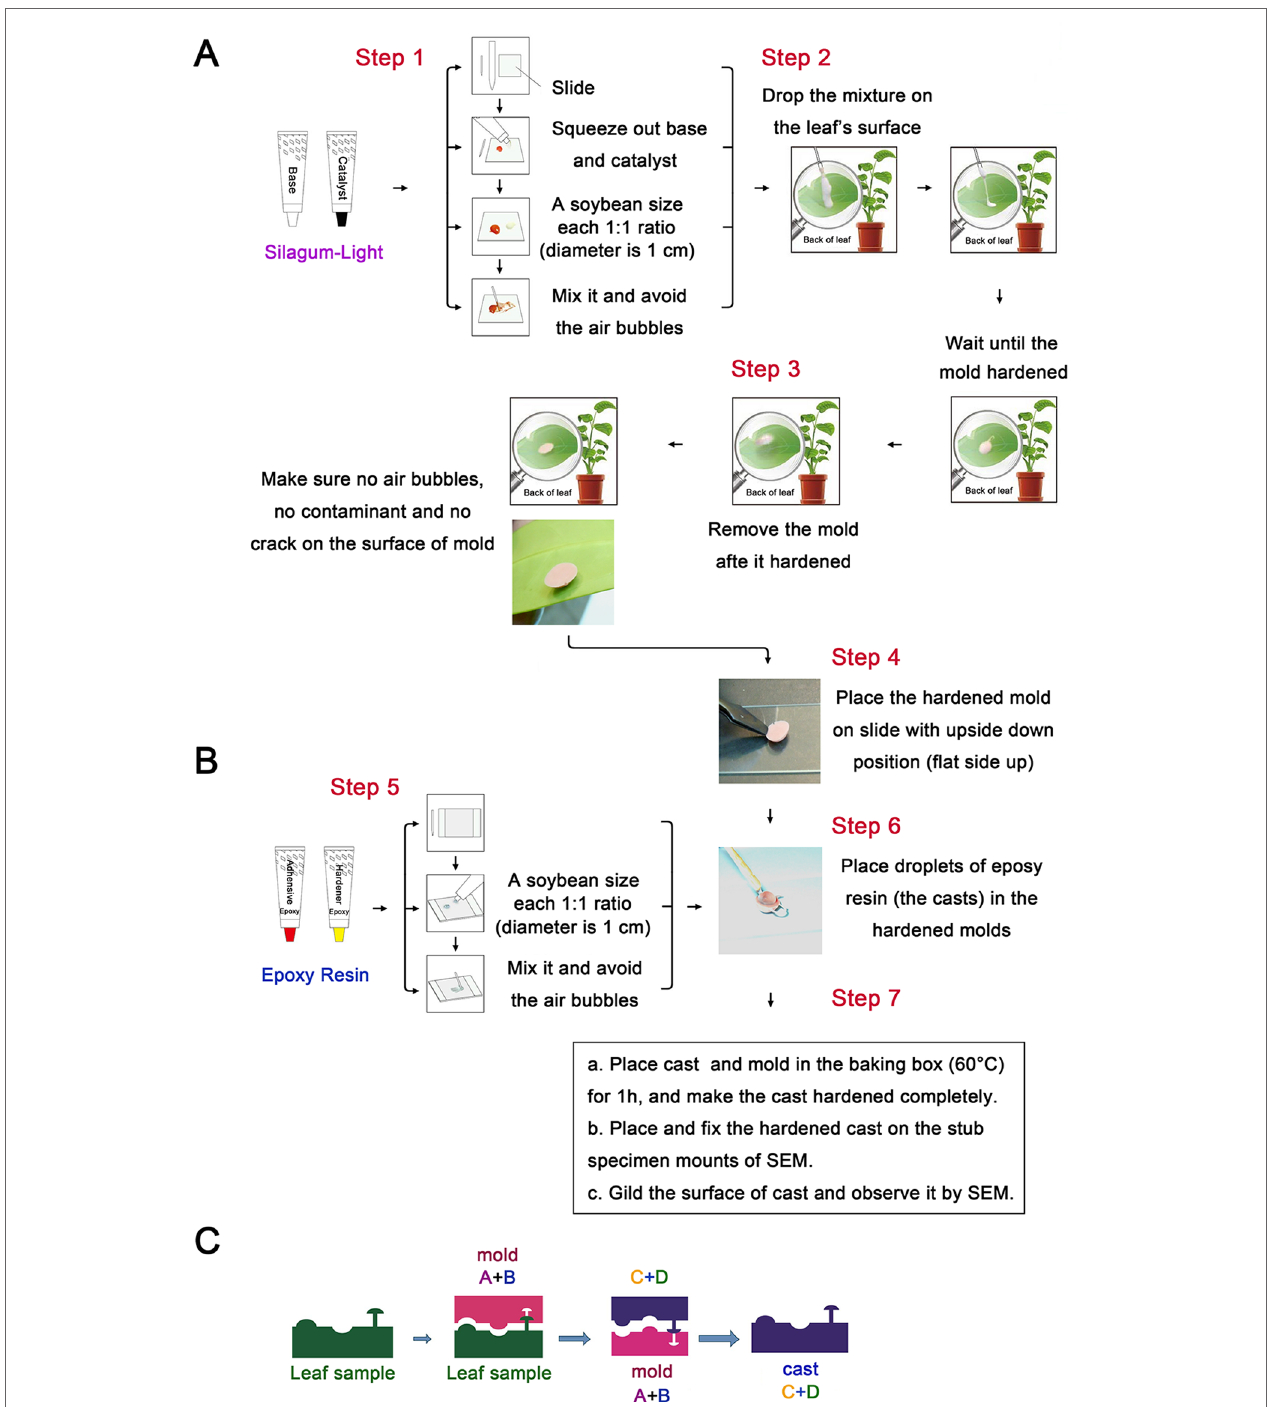
FIGURE 1 | Schematic illustration of the plant surface impression technique (PSIT). (A) The procedure for mold preparation using Silagum-Light. The base and catalyst were added at a soybean size (the diameter is 1 cm) (1:1 ratio) on the slide and mixed in a left to right motion about 10 times, avoiding air bubbles. Subsequently, the mixture was placed on the leaf’s surface and allowed to harden for approximately 5 min. After hardening, the mold was removed and placed on the slide in an inverted position. (B) The procedure for cast preparation using NAN PAO epoxy 906. A soybean size (the diameter is 1 cm) of adhesive and hardener (epoxy resin) was mixed about 10 times, avoiding air bubbles. Following this, droplets of the epoxy resin were placed in the hardened molds. The cast and mold were placed in a baking box (60°C) for 1 h to allow the cast to harden completely. Finally, we placed and fixed the hardened cast on the stub specimen mounts for SEM and gilded the cast surface for SEM observation. (C) The principle of plant surface impression technique. This picture illustrates the principle of mold and cast preparation using Silagum-Light (polyaddition silicone rubber) and epoxy resin (NAN PAO epoxy 906), respectively.